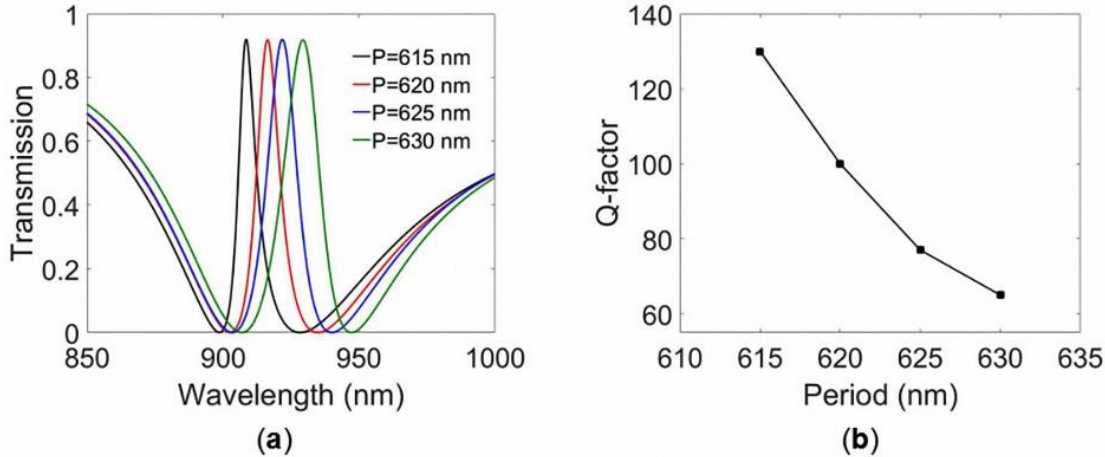
Figure 3. ( a ) Simulated transmission spectra with different period sizes. ( b ) The Q-factors of the EIT- like resonance with different period sizes.